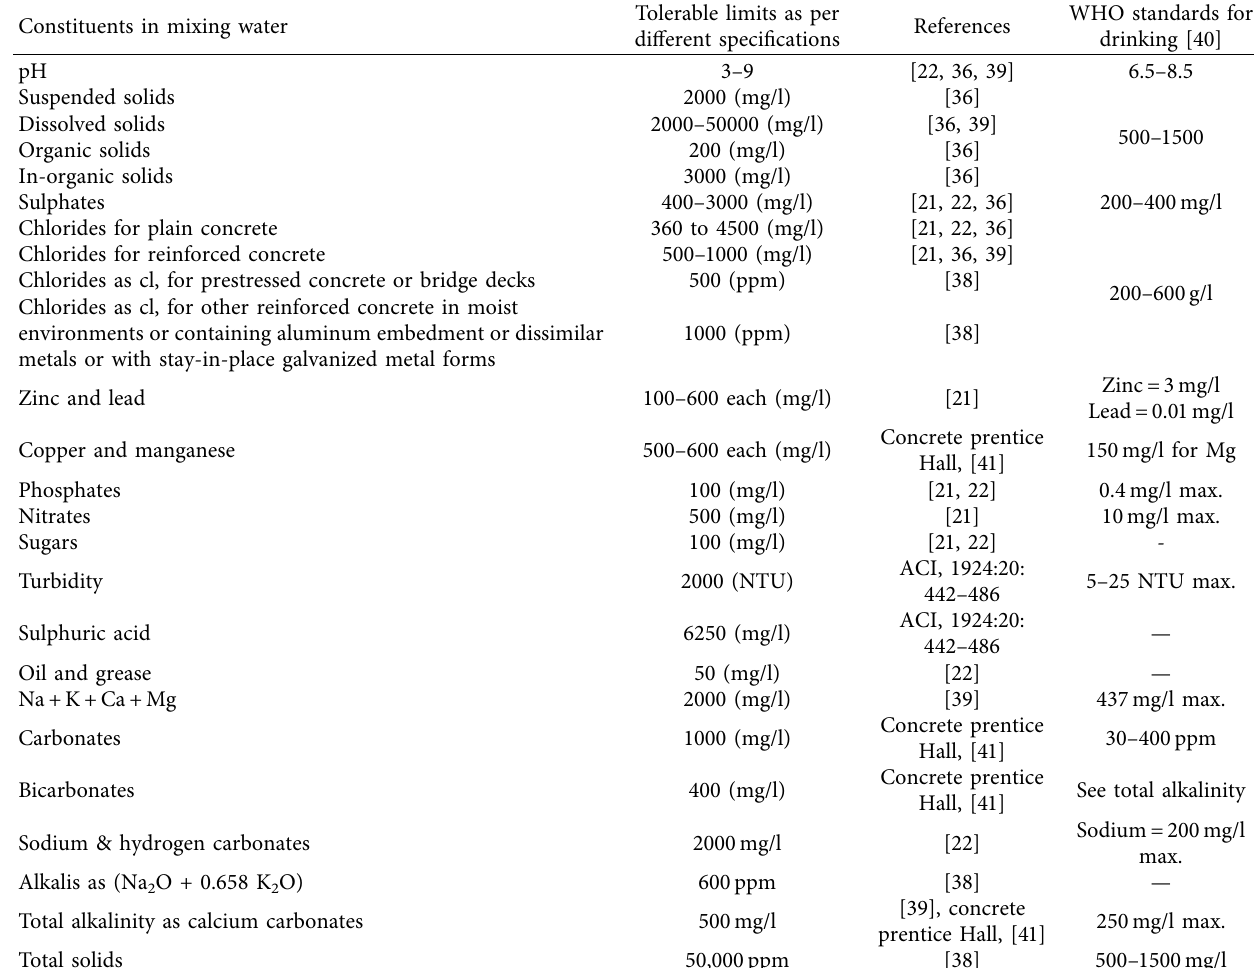
Table 1: Tolerable limits of diferent constituents in water for concrete